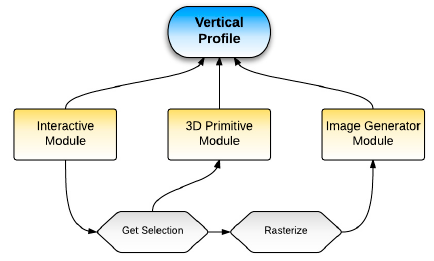
Figure 2. The workflow for creating a vertical profile.